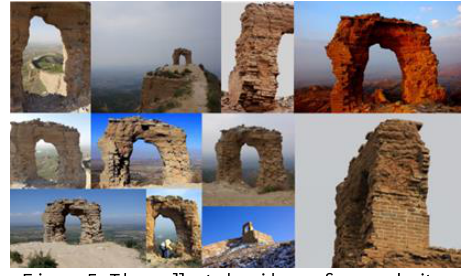
Figure 5. The collected evidence from